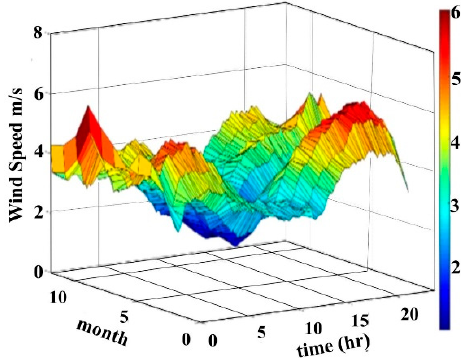
Figure 5. Wind speed ratio (m/s) (2010–2017).